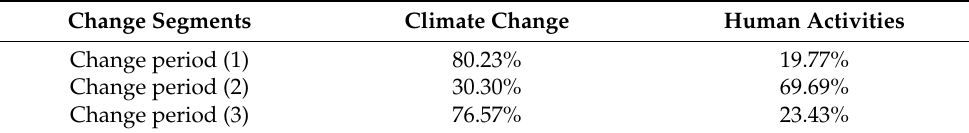
Table 6. Contribution rate of runoff change by the slope change rate cumulant quantity.